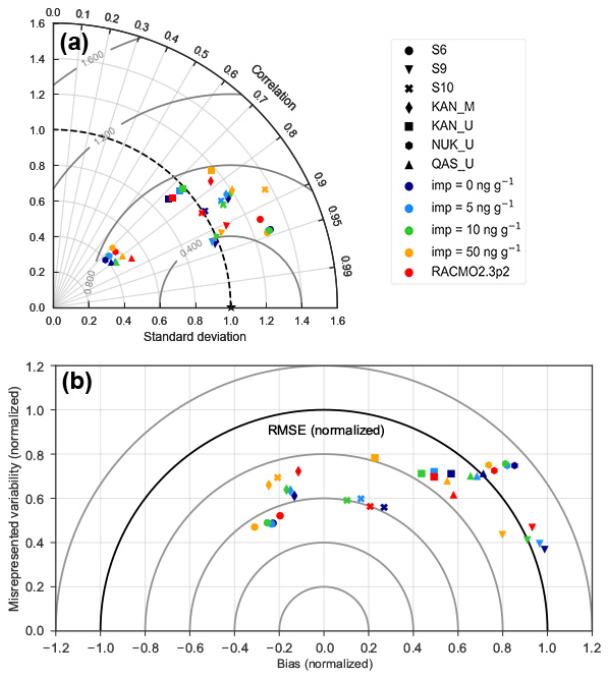
Figure 12. ( a ) Normalized Taylor diagram (Taylor, 2001) for 16d running mean total-sky albedo of RACMO2.3p3 with various im- purity concentrations and RACMO2.3p2 with respect to a selection of K-transect and PROMICE in situ observations for 15:00UTC between 2011 and 2015. The standard deviation is illustrated by the radial distance to the origin; the correlation coefficient by the azimuthal position; and the misrepresented variability, defined as (cid:112) RMSE 2 − bias 2 , by quarter circles with their origin at 1.0 stan- dard deviation. ( b ) Extension to the Taylor diagram, which shows the misrepresented variability on the y axis, bias on the x axis and RMSE on semicircles from the origin. All data are normalized with respect to in situ